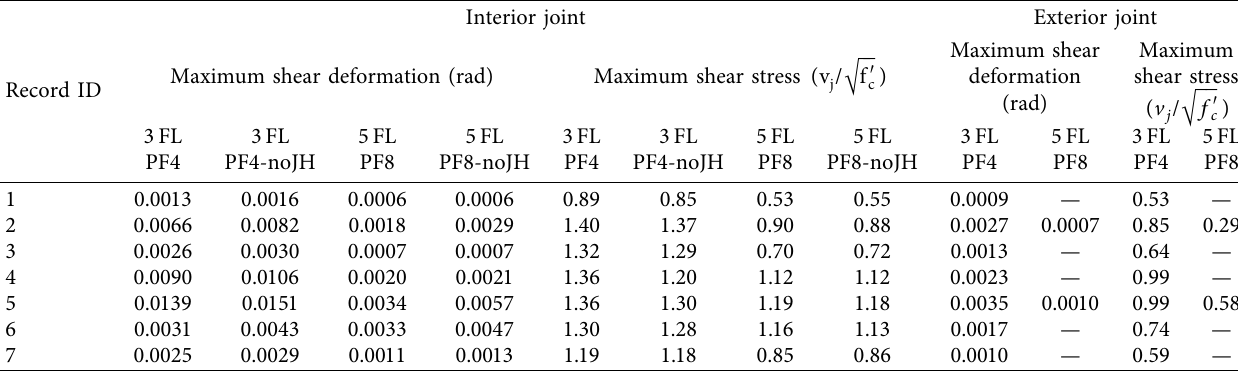
For the exterior joint in PF8, only results from records 2 and 5 are included because they are the largest. Furthermore, the seismic demands obtained from records 1, 2–4, and 5-6 are minimal, and the inclusion of these results is considered insignifcant.